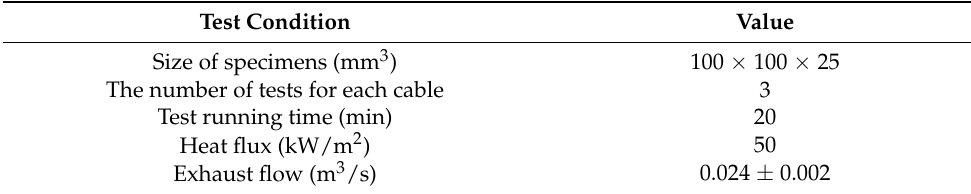
Table 2. Cone calorimeter test